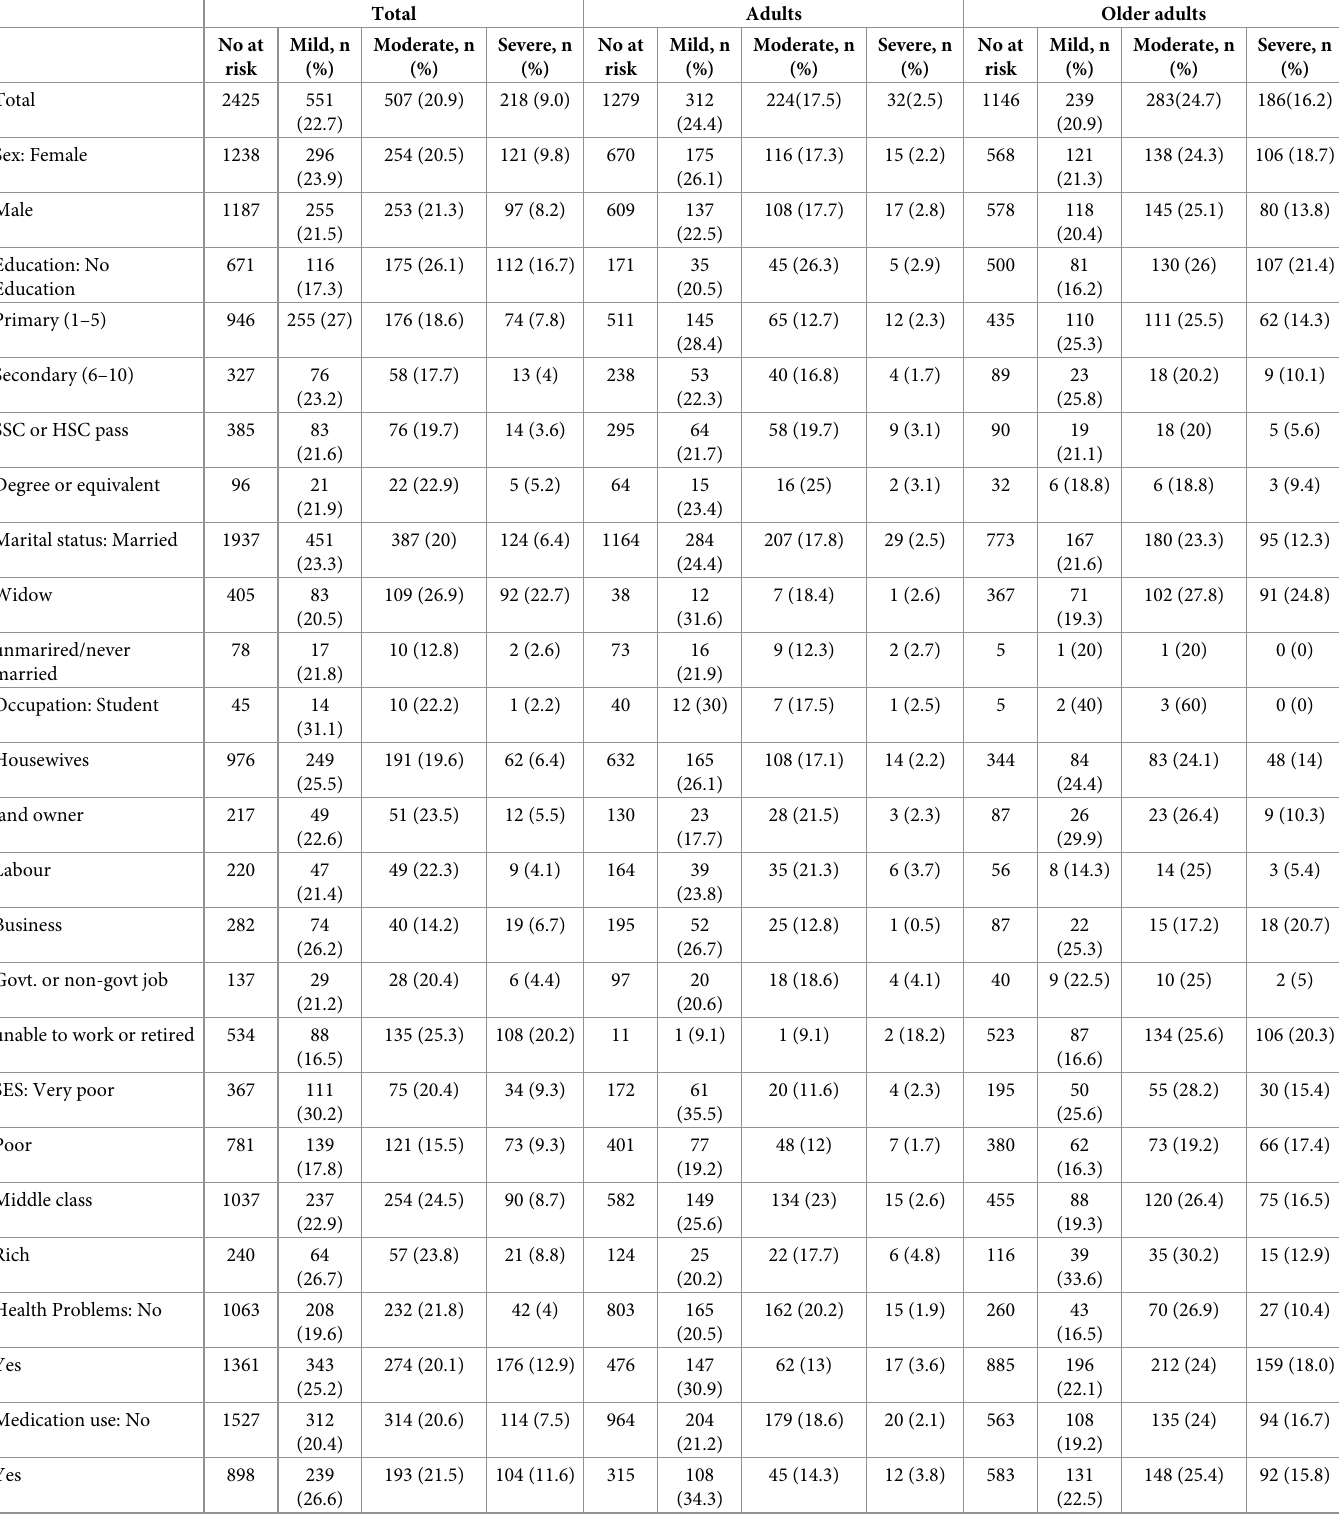
Table 4. Any psychological distress and it’s severity by socio-demographic factors of the total participants and by adults and older